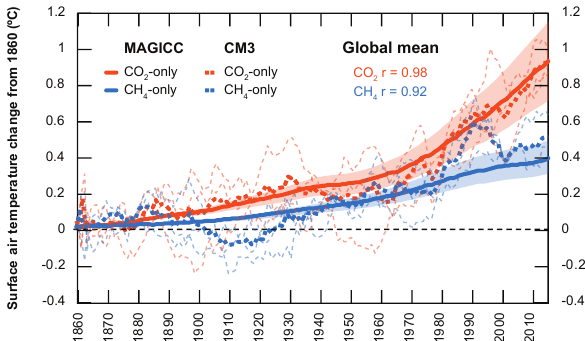
Figure 5. All-forcing global-mean surface air temperature re- sponses in degrees Celsius ( ◦ C) for CM3 (solid red line) and MAGICC (solid grey line) model simulations compared to obser- vations by NOAA ( + ) (https://data.giss.nasa.gov/gistemp/, last ac- cess: 1 October 2018) and NASA (X) (https://www.ncdc.noaa.gov/ cag/time-series/global, last access: 1 October 2018). All annual temperature anomalies shown as change from 20th century average for each dataset. Individual initial condition-driven ensemble mem- bers for CM3 runs shown in thin dashed red lines. Physics-driven ensemble-member range for MAGICC shown as shaded grey. CM3 data are 5-year running means.